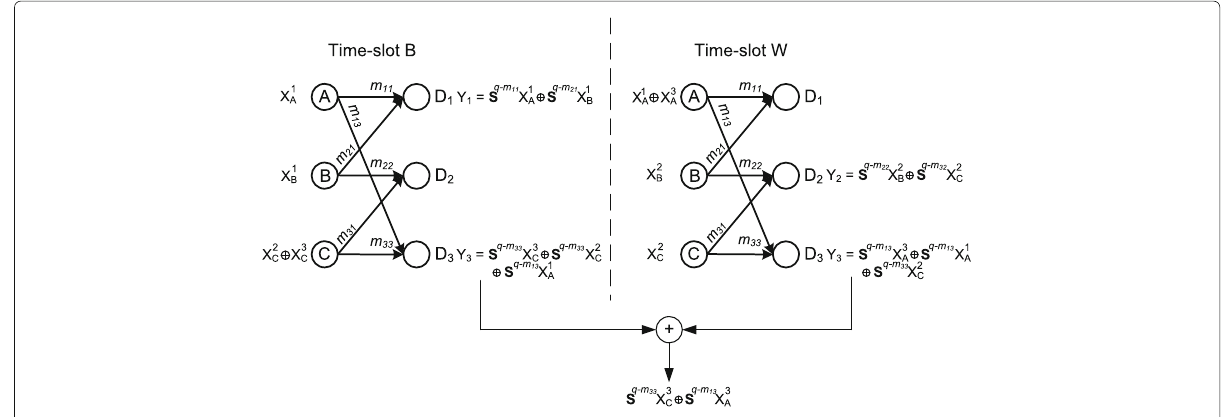
Fig. 6 Achievability strategy for the second layer of the network in Fig.